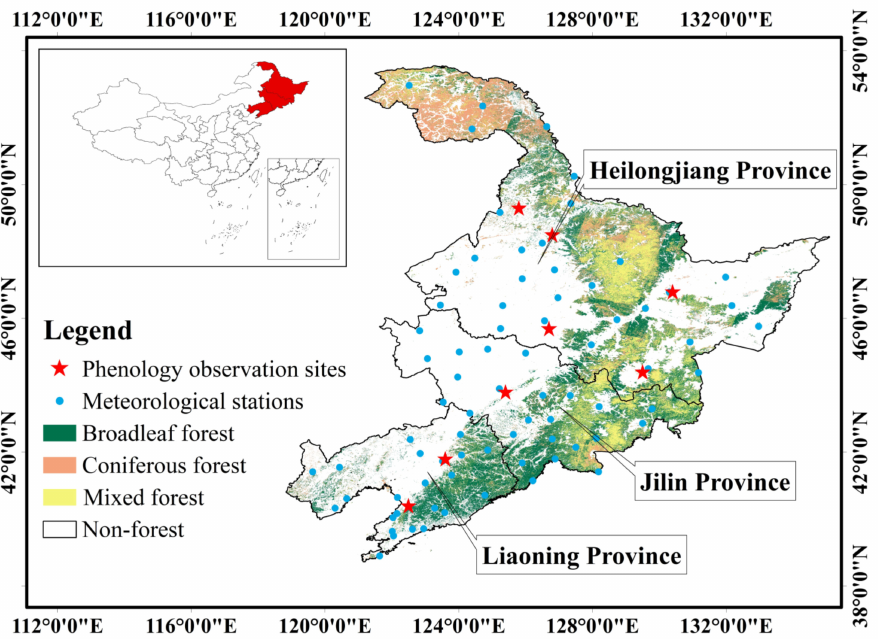
Figure 1. Forest types in northeast China and the locations of the eight phenological observation